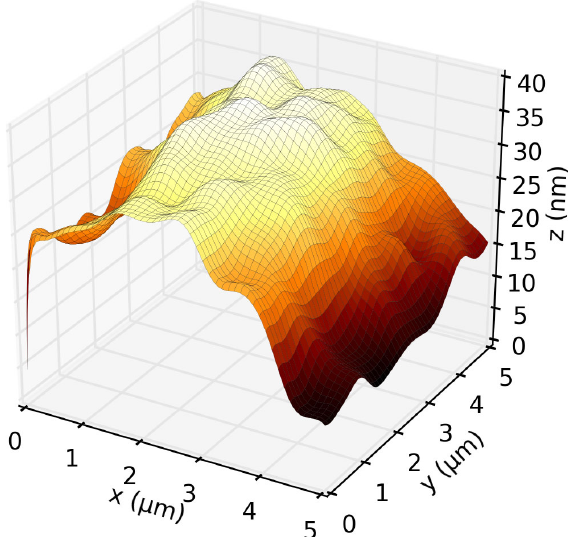
FIG. 2. Surface topography of part of a real-life photocathode. Note that the scales of x axis ( y axis) and z axis